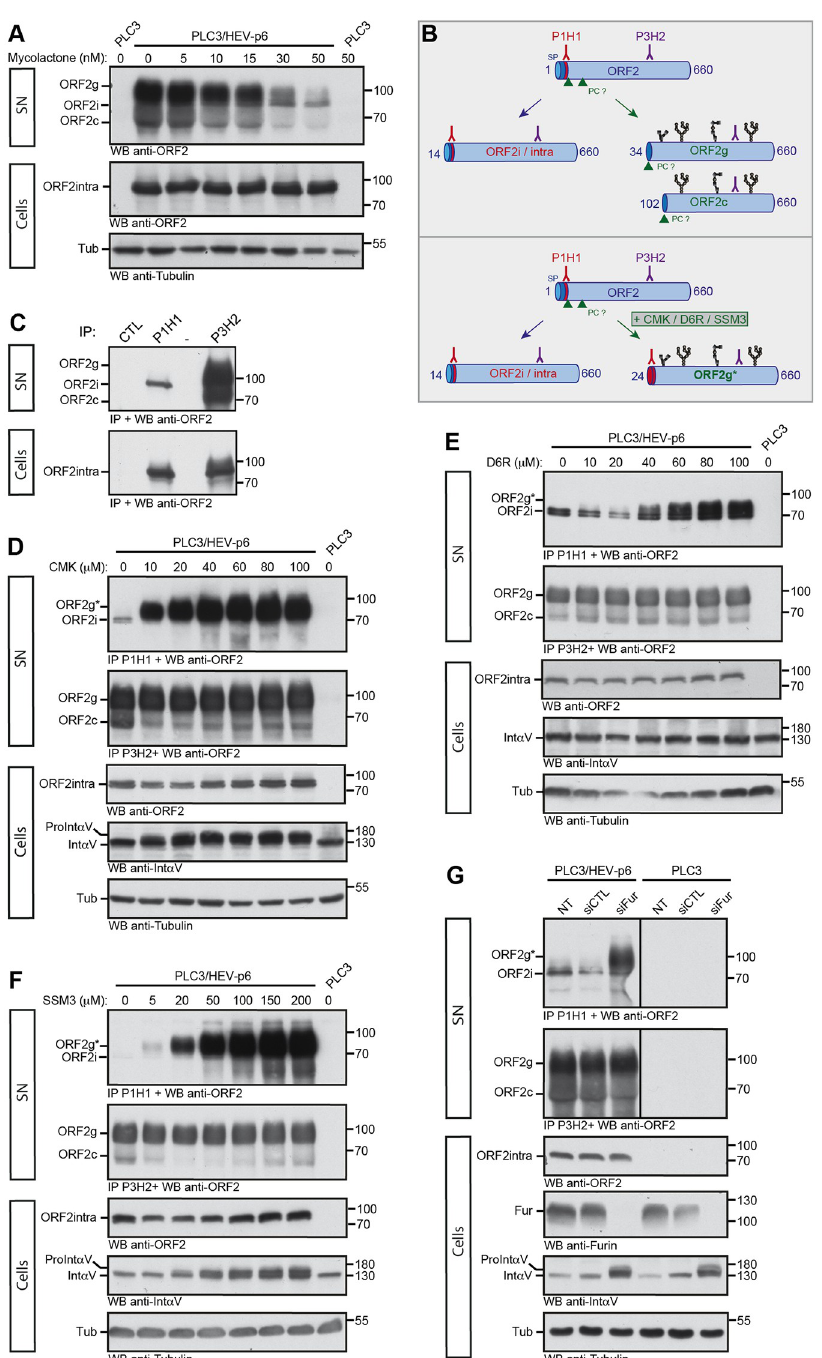
Fig 4. Translocation and maturation of the glycosylated ORF2 forms. (A) Dose-response inhibition of ORF2g/c secretion in mycolactone-treated cells. At 7 d.p.e., PLC3/HEV-p6 and mock cells were treated for 24h with the indicated concentrations of mycolactone (in nM) or maximal volume of the vehicle, ethanol (indicated as 0 nM). Supernatants (SN) and lysates (Cells) were collected and ORF2 proteins were detected by WB using the 1E6 Ab. Tubulin served as control protein loading. (B) Schematic representation of ORF2i/g/c proteins and recognition sites of P1H1 and P3H2 antibodies used to discriminate the different ORF2 forms. SP, signal peptide. PC, proprotein convertase. Glycans are in black. (C) Immunoprecipitation of ORF2 proteins in SN and lysates of PLC3/HEV-p6 cells by P1H1, P3H2 and isotype control (CTL) antibodies immobilized on magnetic beads. ORF2 proteins were detected by WB using the 1E6 Ab. (D-F) At 7 d.p.e., PLC3/HEV-p6 cells were treated with the indicated concentrations